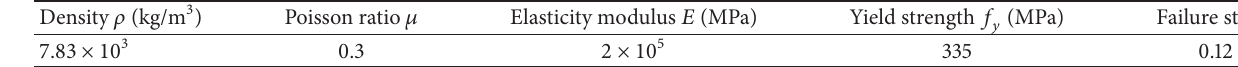
Table 1: Parameters of reinforcement steel.